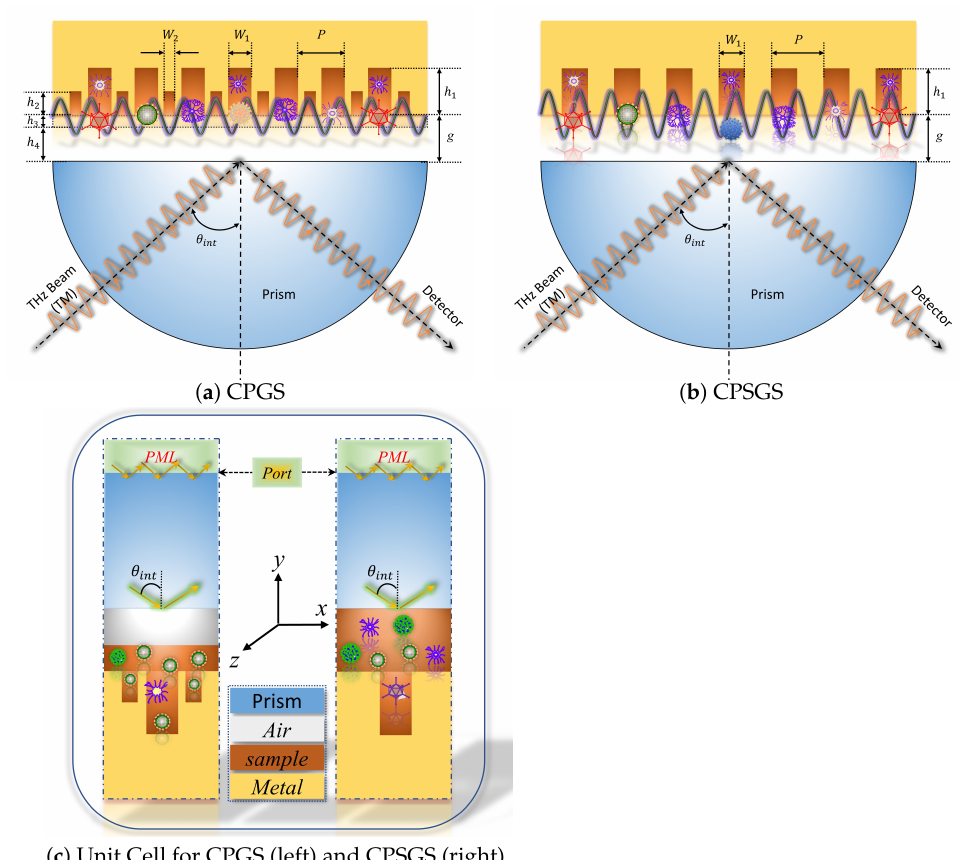
Figure 1. Schematic diagram of THz-SPR biological tiny molecule fingerprint sensing structure based on OTTO-ATR